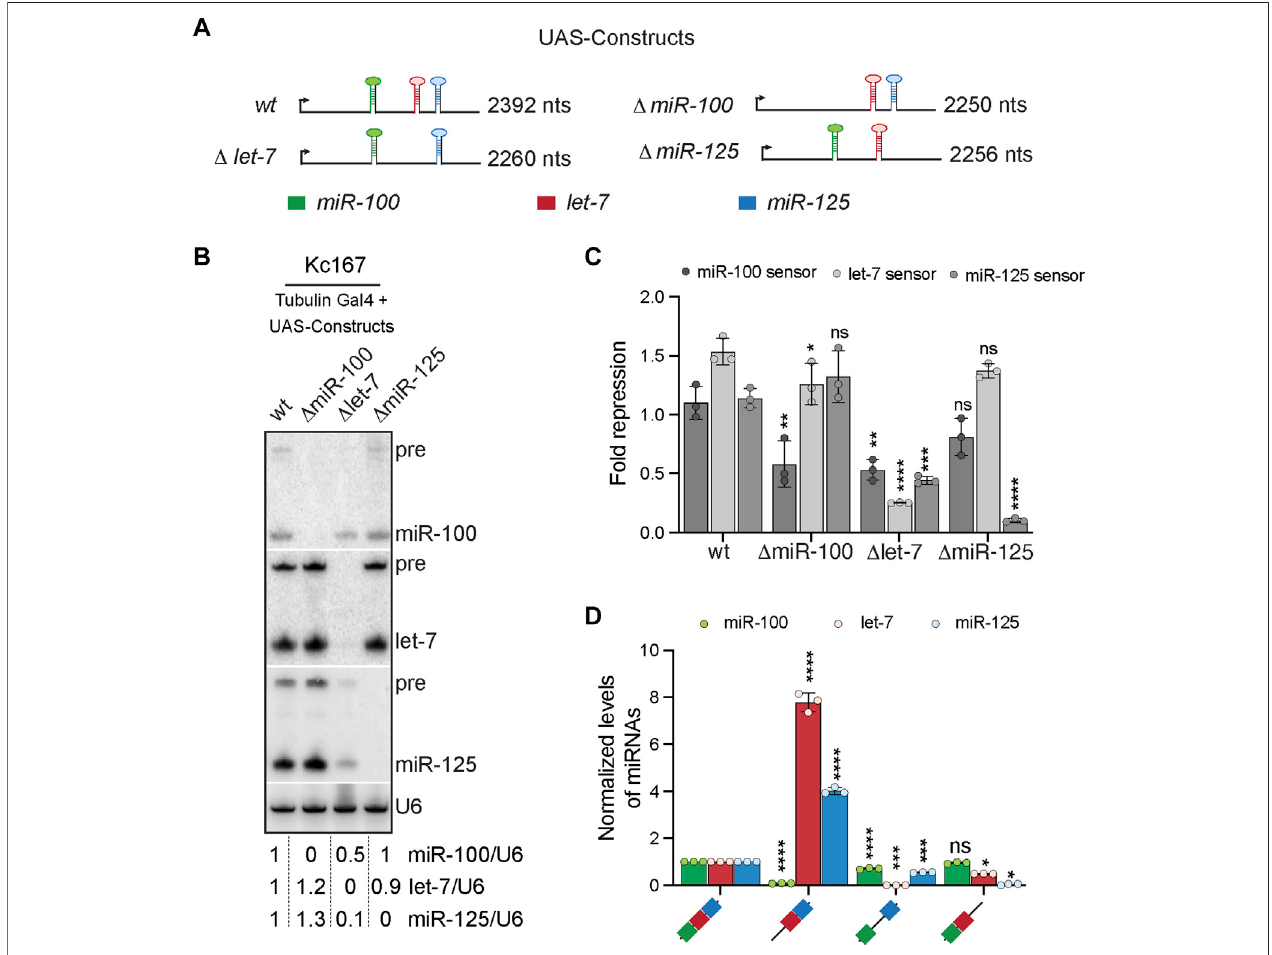
FIGURE 2 | Cross-regulation of let-7-Complex ( let-7-C ) miRNAs. (A) Schematic of the UAS let-7-C constructs for determining the effect of adjacent hairpins in processingof let-7-C miRNAs. (B) SmallRNAnorthernblotanalysisofKc167cellstransfectedwithTubulinGal4and UASlet-7-C expressionplasmidsindicatedinpanel (A) and probed for miR-100 , let-7 and miR-125 . U6snRNA was used asa control for normalization and normalized levels of each of the miRNAs are indicated below the gel. (C) Foldrepressionof miR-100 (darkgreybar), let-7 (lightgreybar)and miR-125 (mediumgreybar)luciferasesensorsinKc167cellstransfectedwith UASlet-7- C cDNA constructs in panel (A) . Data are represented as mean ± SD, n = 3. p -value calculated by ordinary one-way ANOVA for miR-100 sensor is 5.9E-03; for let-7 sensor is 1.97E-06; and for miR-125 sensor is 4.31E-06. Adjusted p -values after applying Bonferroni ’ s correction are represented in the fi gure panel and we used an α level of 0.05 to assess statistical signi fi cance. (D) Expression of miR-100 (green bar), let-7 (red bar), and miR-125 (blue bar) in transgenic lines expressing UAS let-7-C cDNA under the control of let-7-C Gal4 knock-in driver ( G4KI ) as determined by Taqman miRNA assays. The expression plasmids are variants of the let-7-C cDNAs where the miR-100, let-7 or miR-125 stem loops were deleted. Total RNA was extracted from adult fl ies that were in a trans heterozygote let-7-C null mutant of the following genotype: let-7-C GKI / let-7-C KO2 ; UAS transgene/+ . 2S rRNA was used as a control for normalization. Assays were performed in triplicates. Data are representedasmean±SD, n =3. p -valuecalculatedbyordinaryone-wayANOVAformiR-100is9.10 E-11;forlet-7is1.27E-10;andformiR-125is1.28E-11.Adjusted p -values after applying Bonferroni ’ s correction are represented in the fi gure panel and we used an α level of 0.05 to assess statistical signi fi cance. Genotype of strains used: (2D) w 1118 ; let-7-C GKI /let-7-C KO2 , P{neoFRT}40A; {w+, UAS let-7-C miR-100, let-7, miR-125 } VK00033/+; w 1118 ; let-7-C GKI /let-7-C KO2 , P{neoFRT}40A; {w+, UAS let- 7-C Δ miR-100 }VK00033/+;w 1118 ;let-7-C GKI /let-7-C KO2 ,P{neoFRT}40A;{w+,UAS let-7-C Δ let-7 }VK00033/+;w 1118 ;let-7-C GKI /let-7-C KO2 ,P{neoFRT}40A;{w+,UAS